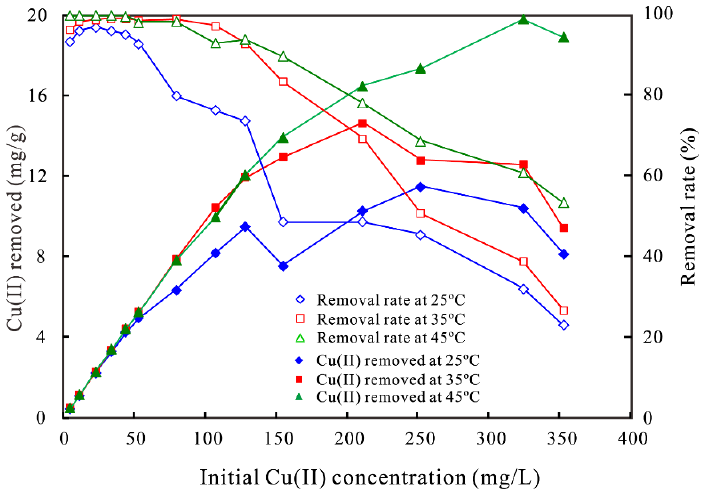
Figure 7. Influence of temperature and initial concentration on Cu (II) removal by SC–HA/C (initial pH 5.0; SC–HA/C dose 0.5 g/50 mL; SC–HA/C particle size < 100 mesh).